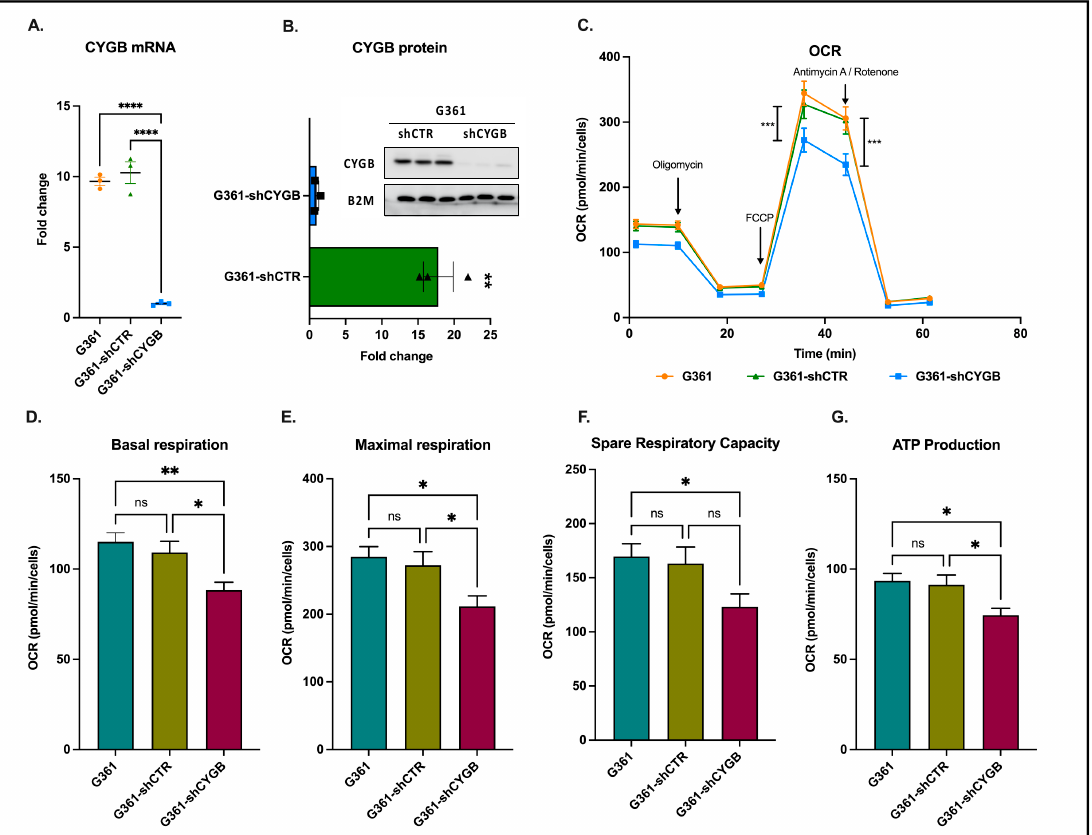
Figure 1. CYGB knockdown reduces mitochondrial respiration. Knockdown of CYGB in G361 cells was validated at mRNA ( A ) and protein ( B ) level. ( C ) The average oxygen consumption rate (OCR) was measured between G361 (untransduced), G361-shCTR (transduction control) and G361-shCYGB (CYGB knockdown). ( D ) Initially, the basal respiration rate was measured. ( E ) After oligomycin injection, ATP production was measured. ( F ) Subsequently, the maximal respiration was measured, after FCCP injection. ( G ) The spare respiratory capacity was measured upon addition of antimycin A and rotenone. Results are depicted as the mean with S.E.M. of three independent experiments (n = 3). One-way ANOVA ( A ), Student t -test ( B ), two-way ANOVA ( C – G ) (* p ≤ 0.05; ** p ≤ 0.01; *** p ≤ 0.001; **** p ≤ 0.0001, ns: non-significant). FCCP: Carbonyl cyanide-4 (trifluoromethoxy) phenylhydrazone.